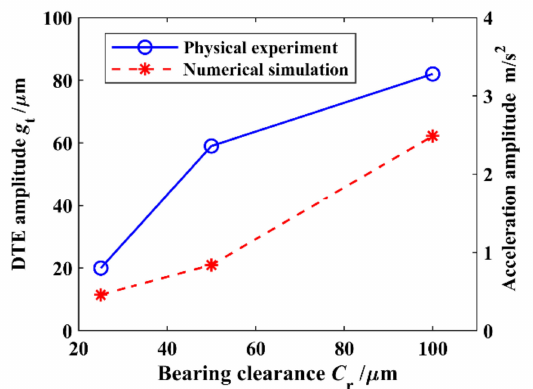
Figure 12. Physical experiment.